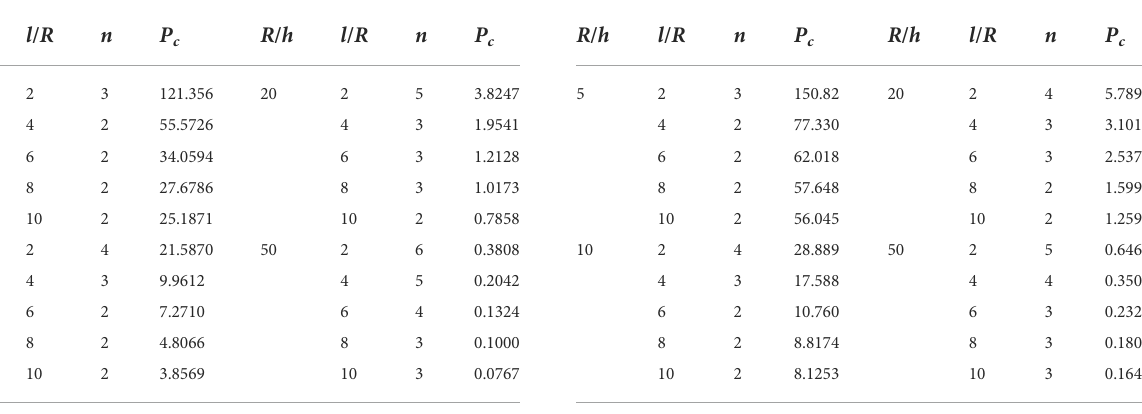
TABLE 11 Critical pressure values with [0/0/0/90]s con fi guration and Carbon/Epoxy composite